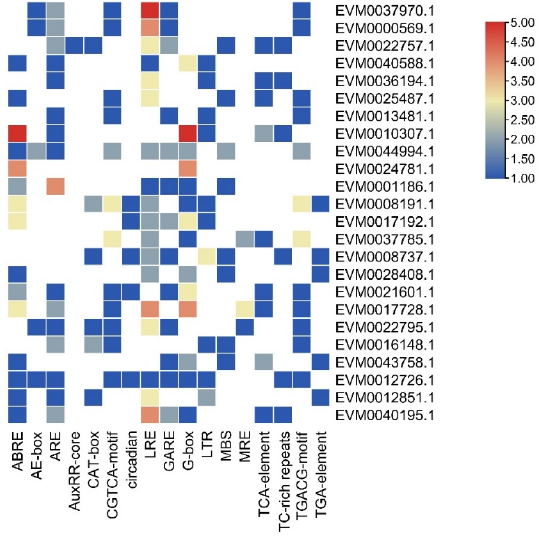
Figure 5. Heatmap of cis -regulatory elements detected in the promoter sequences of EjALMT genes. Maximum number of cis -regulatory elements are denoted by red, medium by yellow, and minimum cis -regulatory elements are denoted by red, medium by yellow, and minimum by blue boxes. Maximum number of by blue